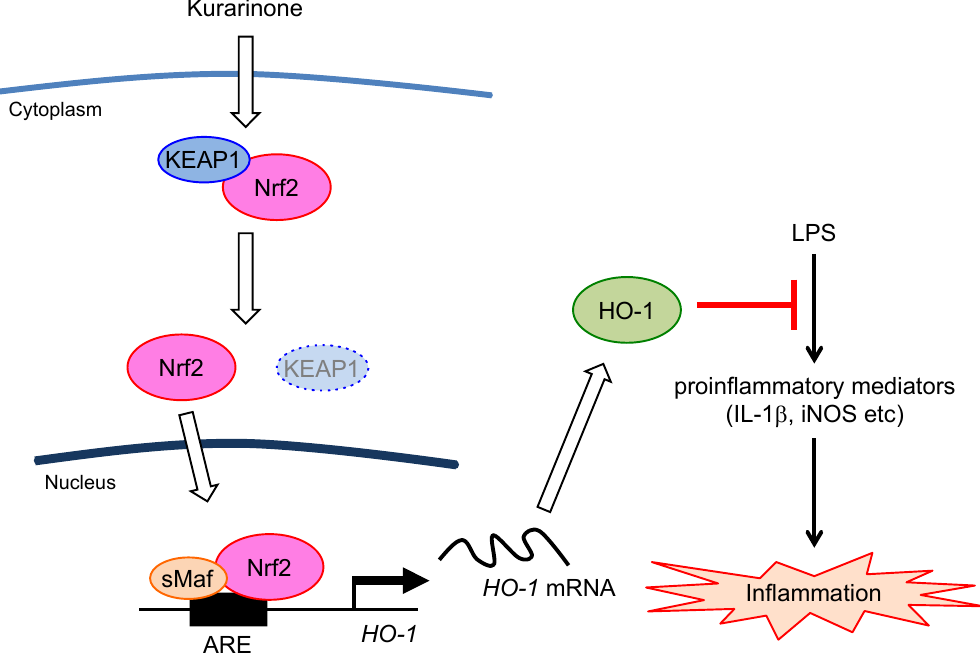
Figure 5. Schematic illustration showing the signal transduction pathway associated with the anti-inflammatory effects of kurarinone on LPS-stimulated RAW264.7 macrophage cells. Kurarinone induces the nuclear accumulation of Nrf2 and upregulates HO-1 protein expression, which attenuates the LPS-mediated production of proinflammatory mediators.